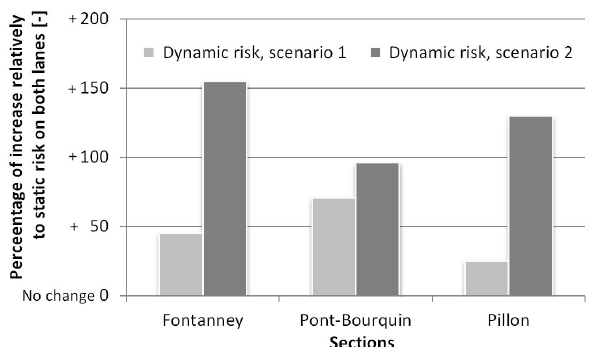
Fig. 7. Calculated dynamic risks normalized to static risk for the two scenarios (Fig. 5). Scenario 1: free road; scenario 2: traffic lights. For example, a value of about 100% for the Pont-Bourquin section with scenario 2 means that the dynamic risk for this section is nearly 2 times higher than the static risk on the same